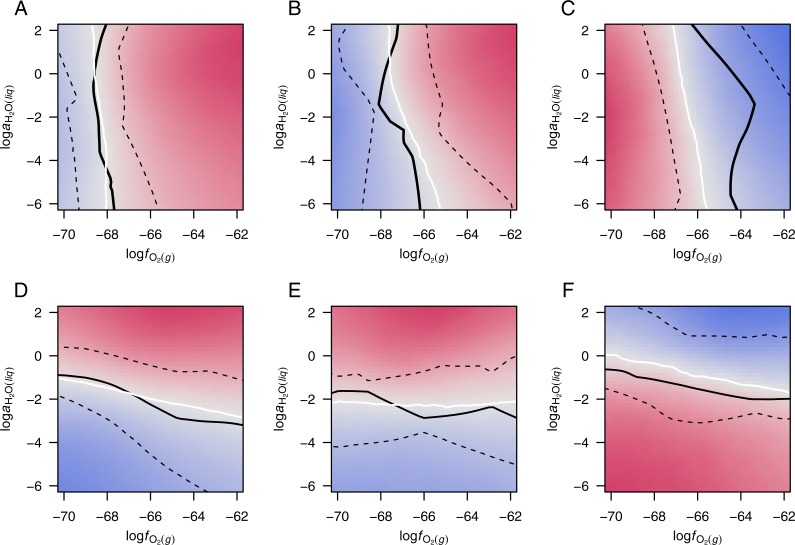
Merged potential diagrams for proteomic transformations.Plots are shown for (A) 13 datasets for colorectal cancer and (B) 11 datasets for pancreatic cancer with ΔZC > 0.01, (C) eight datasets for hypoxia or 3D culture with ΔZC <  − 0.01, (D) 10 datasets for colorectal cancer and (E) eight datasets for pancreatic cancer with \documentclass[12pt]{minimal}
\usepackage{amsmath}
\usepackage{wasysym}
\usepackage{amsfonts}
\usepackage{amssymb}
\usepackage{amsbsy}
\usepackage{upgreek}
\usepackage{mathrsfs}
\setlength{\oddsidemargin}{-69pt}
\begin{document}
}{}$\Delta {\overline{n}}_{{\mathrm{H}}_{2}\mathrm{O}}\gt 0.01$\end{document}Δn¯H2O>0.01, and (F) 12 datasets for hyperosmotic stress with \documentclass[12pt]{minimal}
\usepackage{amsmath}
\usepackage{wasysym}
\usepackage{amsfonts}
\usepackage{amssymb}
\usepackage{amsbsy}
\usepackage{upgreek}
\usepackage{mathrsfs}
\setlength{\oddsidemargin}{-69pt}
\begin{document}
}{}$\Delta {\overline{n}}_{{\mathrm{H}}_{2}\mathrm{O}}\lt -0.01$\end{document}Δn¯H2O<−0.01. Red and blue colors denote higher relative potential for formation of up- and down-expressed proteins, respectively. White lines are equipotential lines, where the mean weighted rank difference of affinity (WRD; Eq. (3)) of the included datasets is 0; black lines show the median and interquartile range of the WRD = 0 lines for individual datasets (Fig. S3). See text for details.